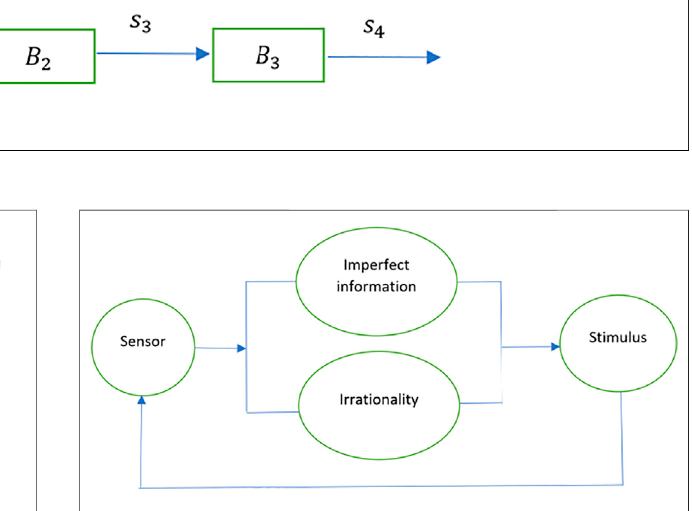
FIGURE 12 | Composition of sheaves in a voice assistant social robot.